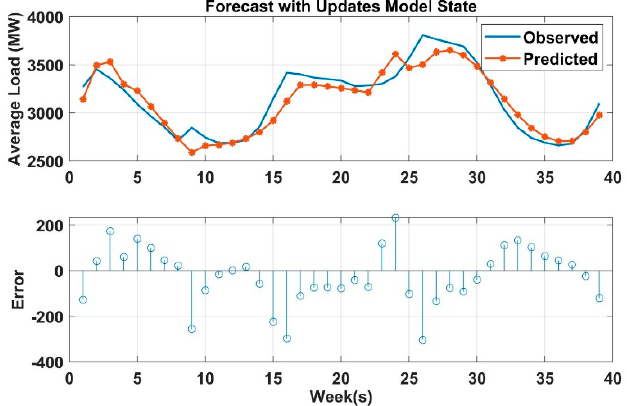
Figure 21. Comparison of per-week forecast future time series with test data (observed value).